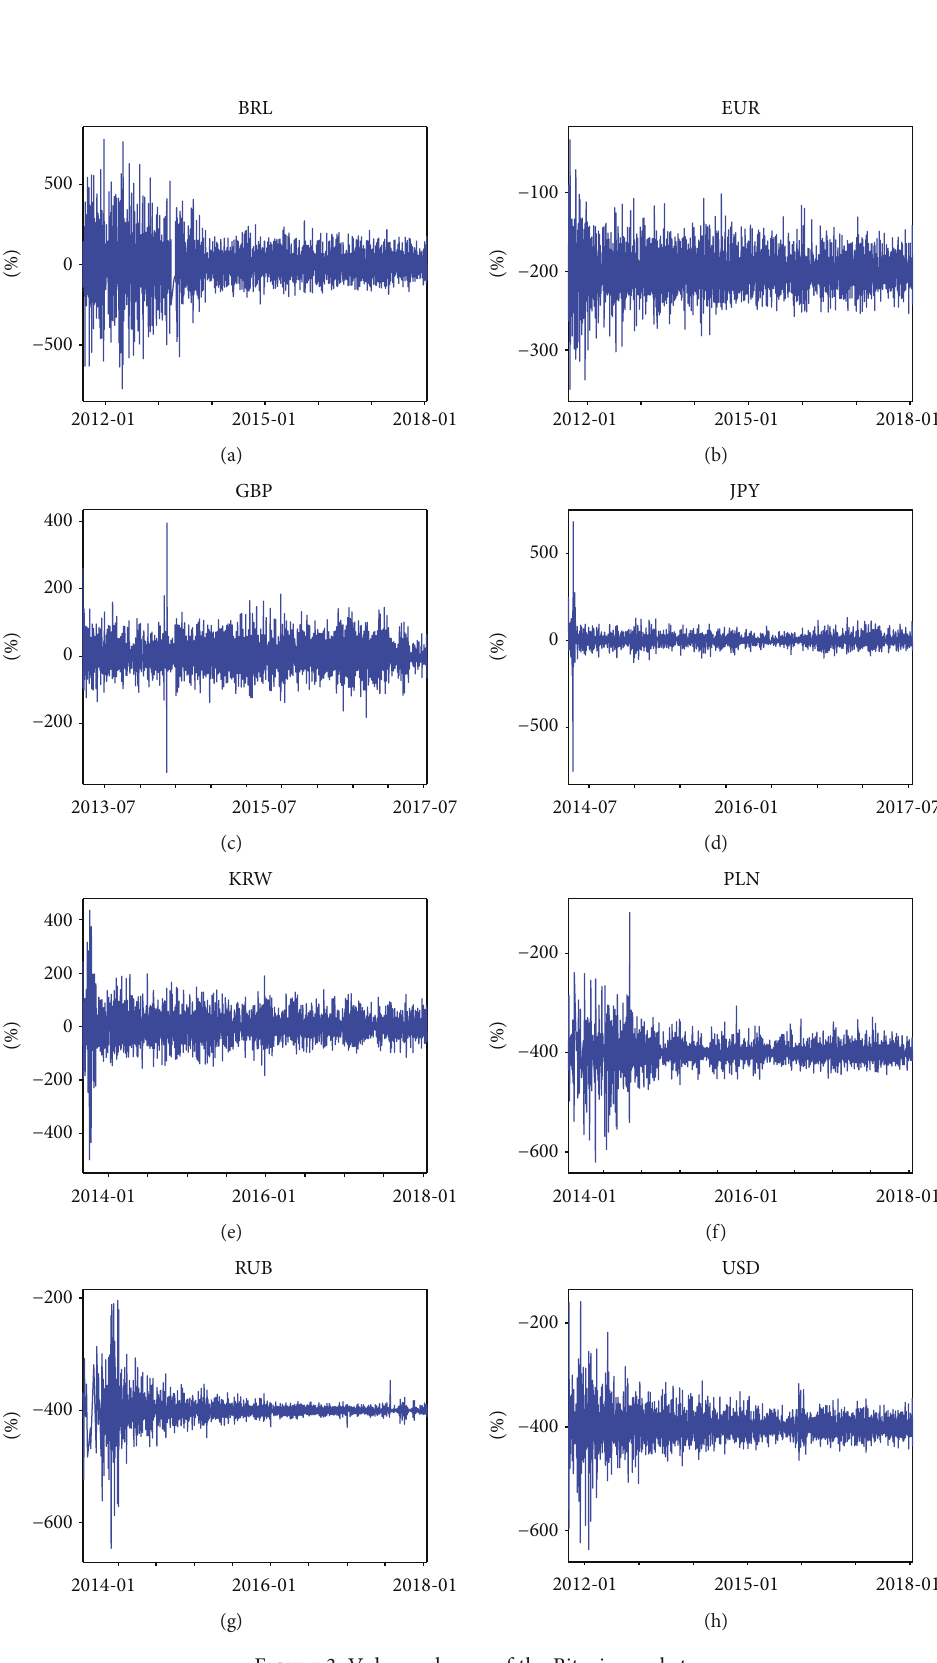
Figure 3: Volume change of the Bitcoin